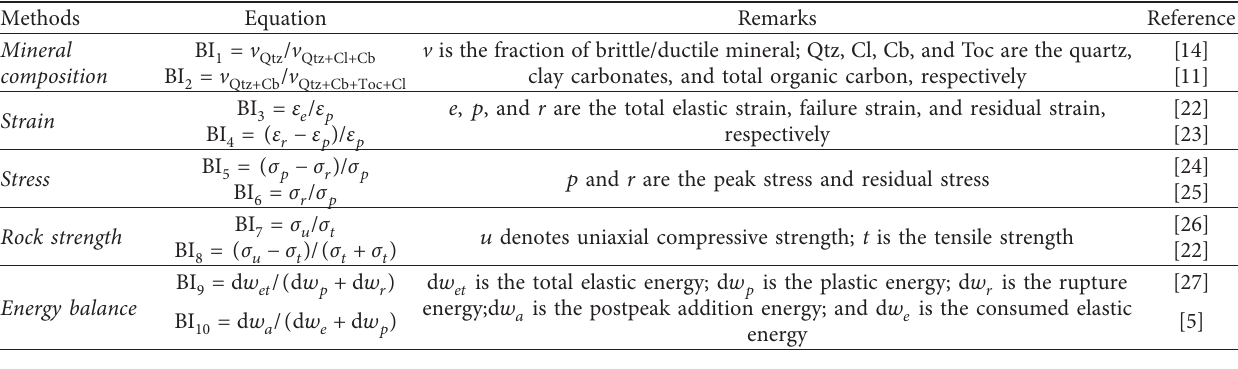
Table 1: Several methods for calculating rock brittleness.